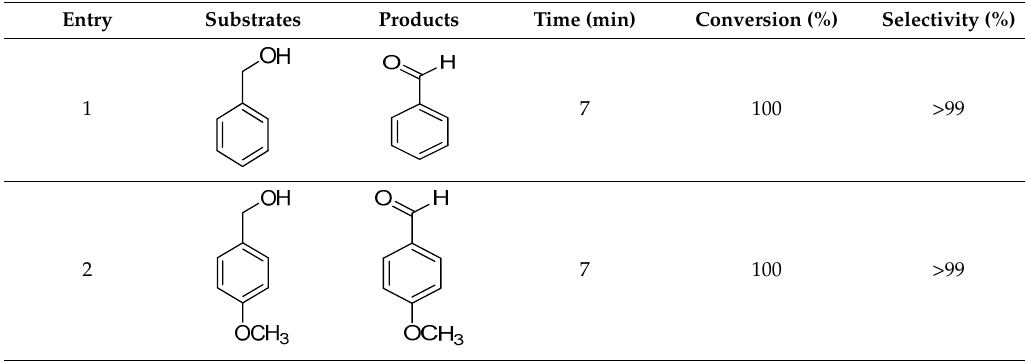
Table 7. Catalytic performance in the aerobic oxidation of benzylic and aliphatic alcohols.